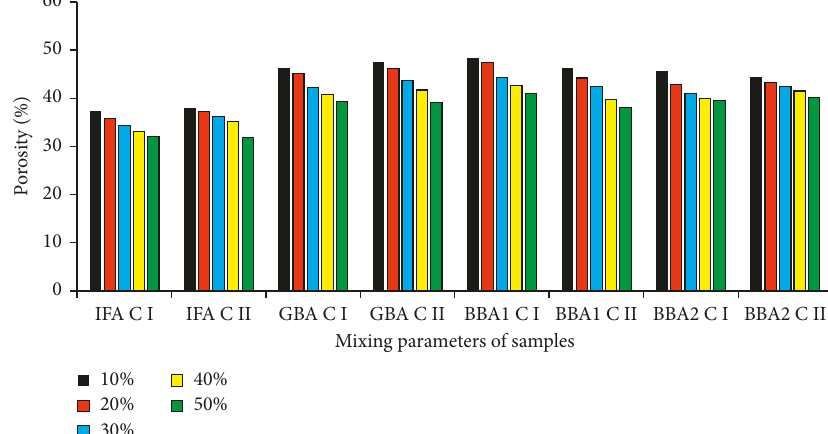
Figure 9: Relationship of porosity for FA- and BA-based sample. IFA: ˙Isken FA; C: CEM; GBA: G¨oknur BA; BBA: Bor BA.